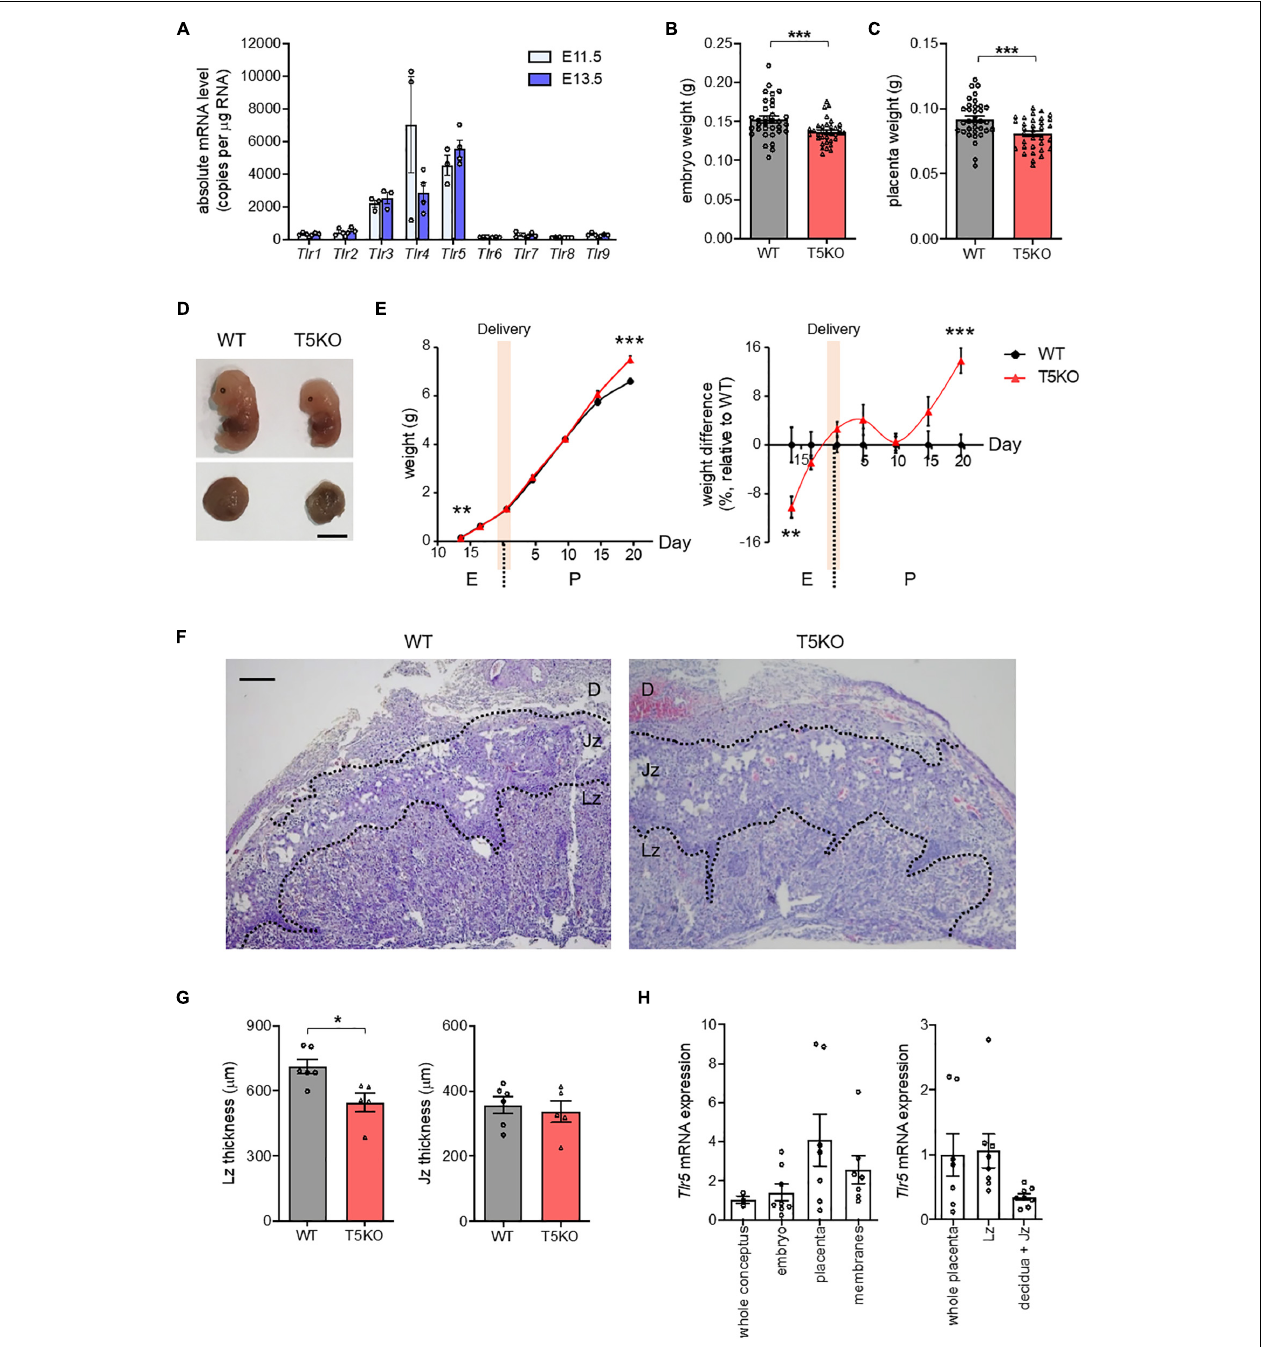
FIGURE 1 | TLR5 deficiency compromised placental labyrinthine development. (A) Mated wild type (WT) C57BL/6J female mice were sacrificed at indicated gestational days. Presence of vaginal plug was defined as embryonic day 0.5 (E0.5). Absolute copy numbers of mRNA transcripts in E11.5 and E13.5 placenta were determined using droplet digital PCR ( n = 3–4 litters, one randomly picked placenta from each litter). (B–D) Pregnant WT and TLR5-knockout (T5KO) mice were sacrificed at E13.5 ( n = 33–34 embryos from 5 litters). (B) Embryo and (C) placenta weights were measured. (D) Photographs of representative embryos and placentas are shown. Scale bar is 5 mm. (E) Embryo and pup weights from E13.5 to postpartum day 20.5 (P20.5, weaning) were recorded. The body weights relative to wild type controls were shown on the right panel. The shaded area indicates the delivery periods ( n = 33–34 embryos from 5 litters for E13.5; n = 33–35 embryos from 4 litters for E16.5; n = 38–39 pups from 4–5 litters for P0.5; n = 25–33 pups from 4 litters for P4.5; n = 31–37 pups from 4 litters for P9.5; n = 25–31 pups from 4 litters for P14.5; n = 40–41 pups from 5 litters for P19.5). (F,G) Sections of E13.5 placentas were subjected to hematoxylin-eosin staining. (F) Representative images are shown. Scale bar is 100 µ m. Maternal decidua (D), junctional zone (Jz) and labyrinthine zone (Lz) are denoted. (G) The thicknesses of Lz and Jz were measured. Each dot represents the average thickness for one litter ( n = 5–6 litters). (H) The relative Tlr5 mRNA expression at different compartments in WT (left panel) conceptus and (right panel) placenta at E13.5 was examined. Rn18s was used as the housekeeping control ( n = 8 conceptuses). Data are represented as mean ± SEM. The differences between WT and T5KO mice were determined by two-tailed Student’s t -test. * P < 0.05, ** P < 0.01, *** P < 0.001.